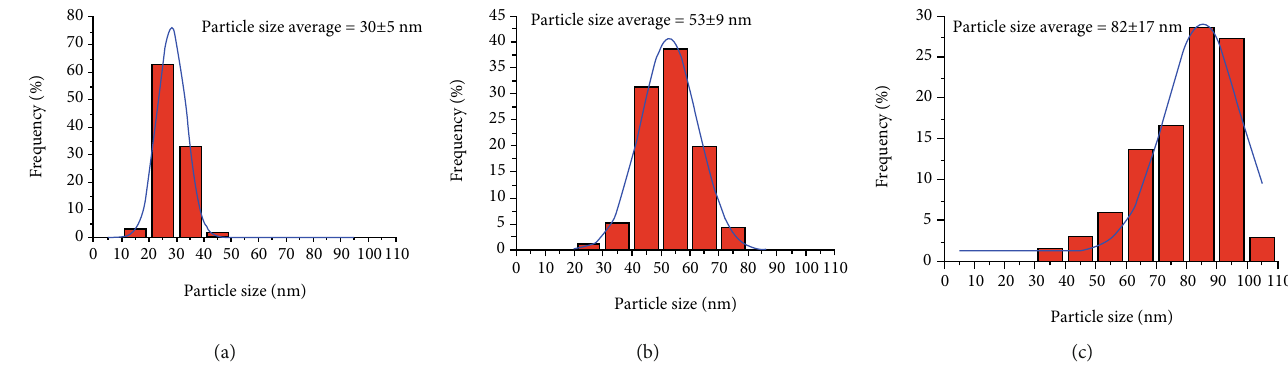
Figure 3: Particle size distribution of Mg-doped ZnO annealed at (a) 400, (b) 500, and (c) 550 ° C.